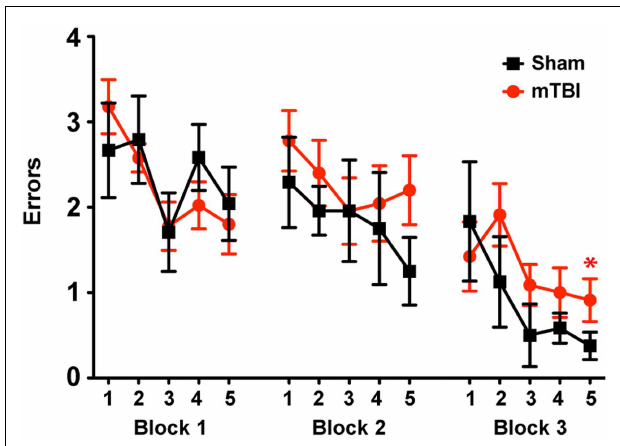
FIGURE 5 | Repetitive mTBI causes significant cognitive impairments 2months after injury .Wild-type C57BL/6J mice (male, 3months of age) received three mild impacts (mTBI) or underwent sham procedures (sham). Spatial learning and memory was assessed using the radial arm water maze (RAWM) paradigm 2months after injury. On day 1 during the training phase, mice are trained for 15 trials, with trials alternating between visible and hidden platforms. On day 2 during the testing phase, mice are tested for 15 trials with a hidden platform. Entry into an incorrect arm is scored as an error, and the errors are averaged over training blocks (three consecutive trials). Learning and memory deficits were quantified as the number of entry arm errors made prior to finding the target platform. n = 8 (sham) and 15 (mTBI) mice/group. Mean ± SEM; * P < 0.05, repeated measures